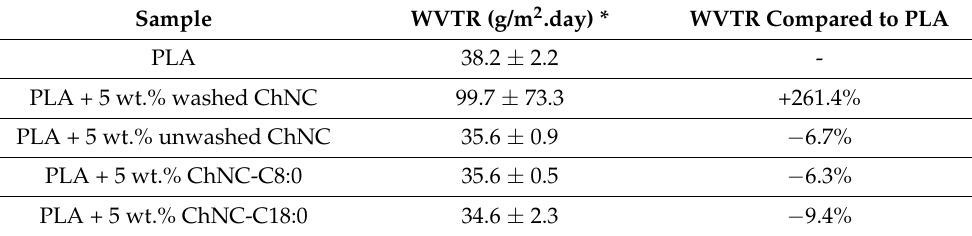
Table 3. Water vapor transmission rate (WVTR) of PLA nanocomposites containing 5 wt.% (modi- fied) ChNC.